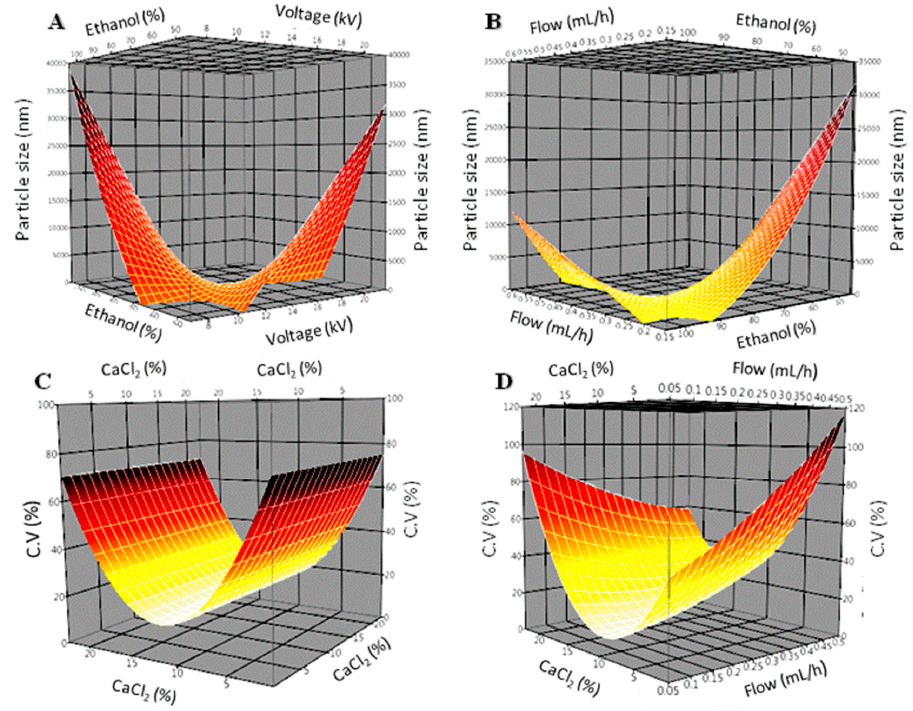
Figure 5. Response surface plots showing the most significant interactions. Ethanol conc. vs. voltage, and flow vs. ethanol conc. for size particle ( A , B ); CaCl 2 quadratic effect, and CaCl 2 vs. flow, for CV ( C , D ).